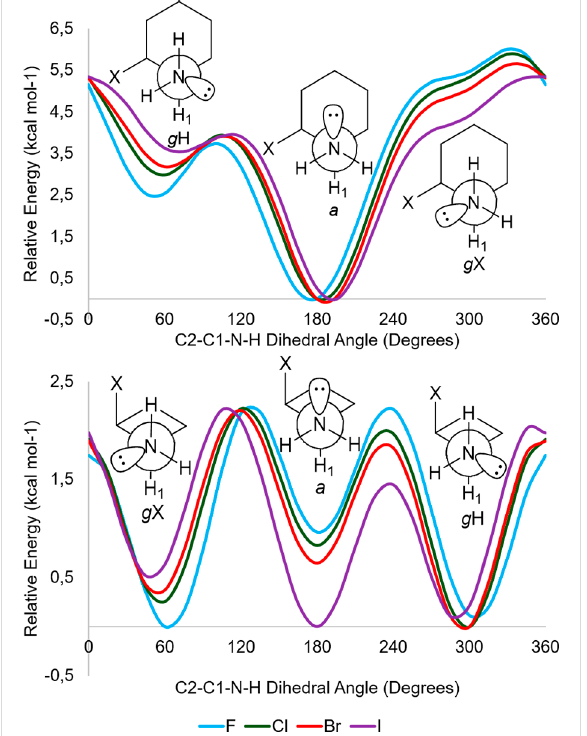
Figure 3: Potential energy surfaces (PESs) for cis -2-halocyclohexyl- amines for the C2–C1–N–H dihedral angle rotation at M06-2X/aug-cc- pVDZ in ae (top) and ea (bottom)